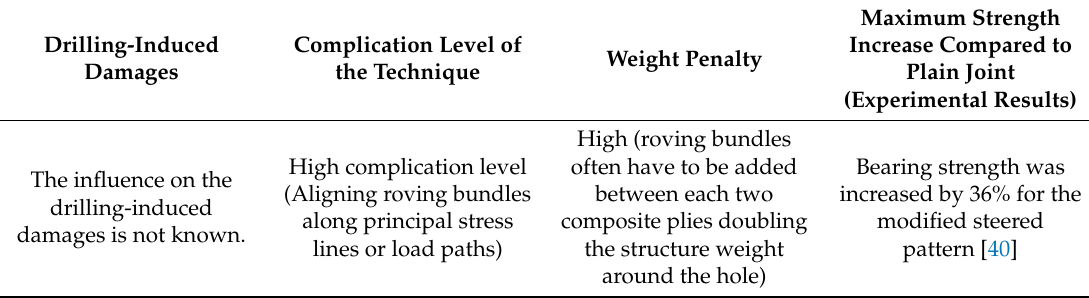
Maximum Strength Increase Compared to Weight Penalty Plain Joint (Experimental Results)